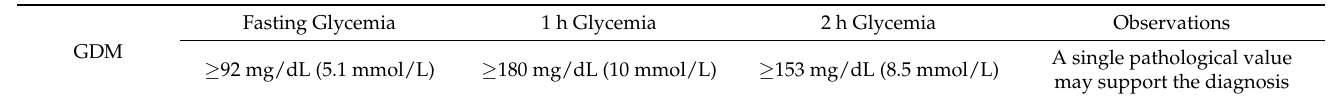
Table 1. Diagnosis criteria for GDM (OGTT with 75 g anhydrous glucose). Fasting Glycemia 1 h Glycemia GDM